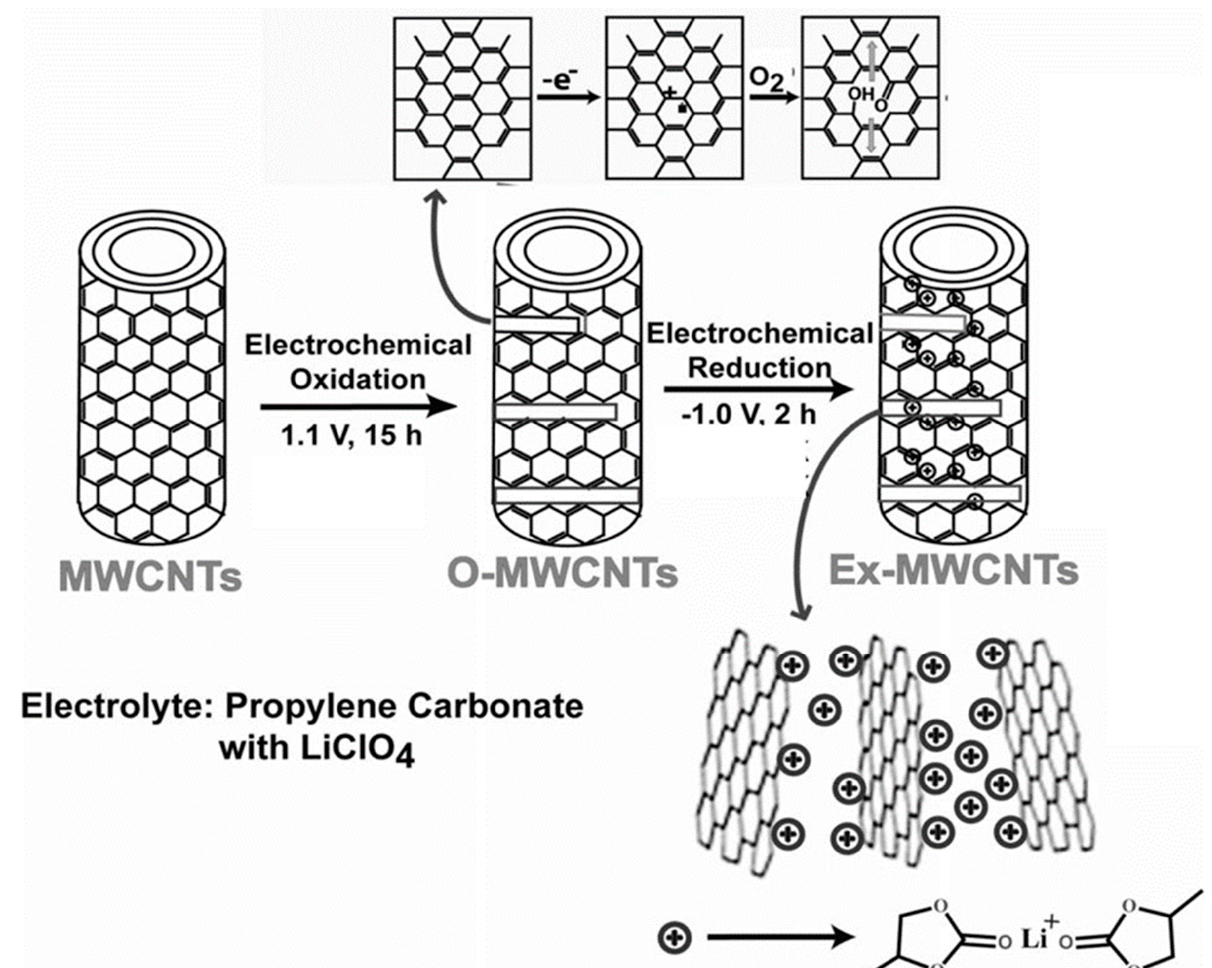
Figure 4. Electrochemical cutting of MWCNTs to prepare GQDs. The process is associated with electrochemical oxidation in step 1 followed by an electrochemical reduction in step 2. Reprinted with permission from Ref. [43].